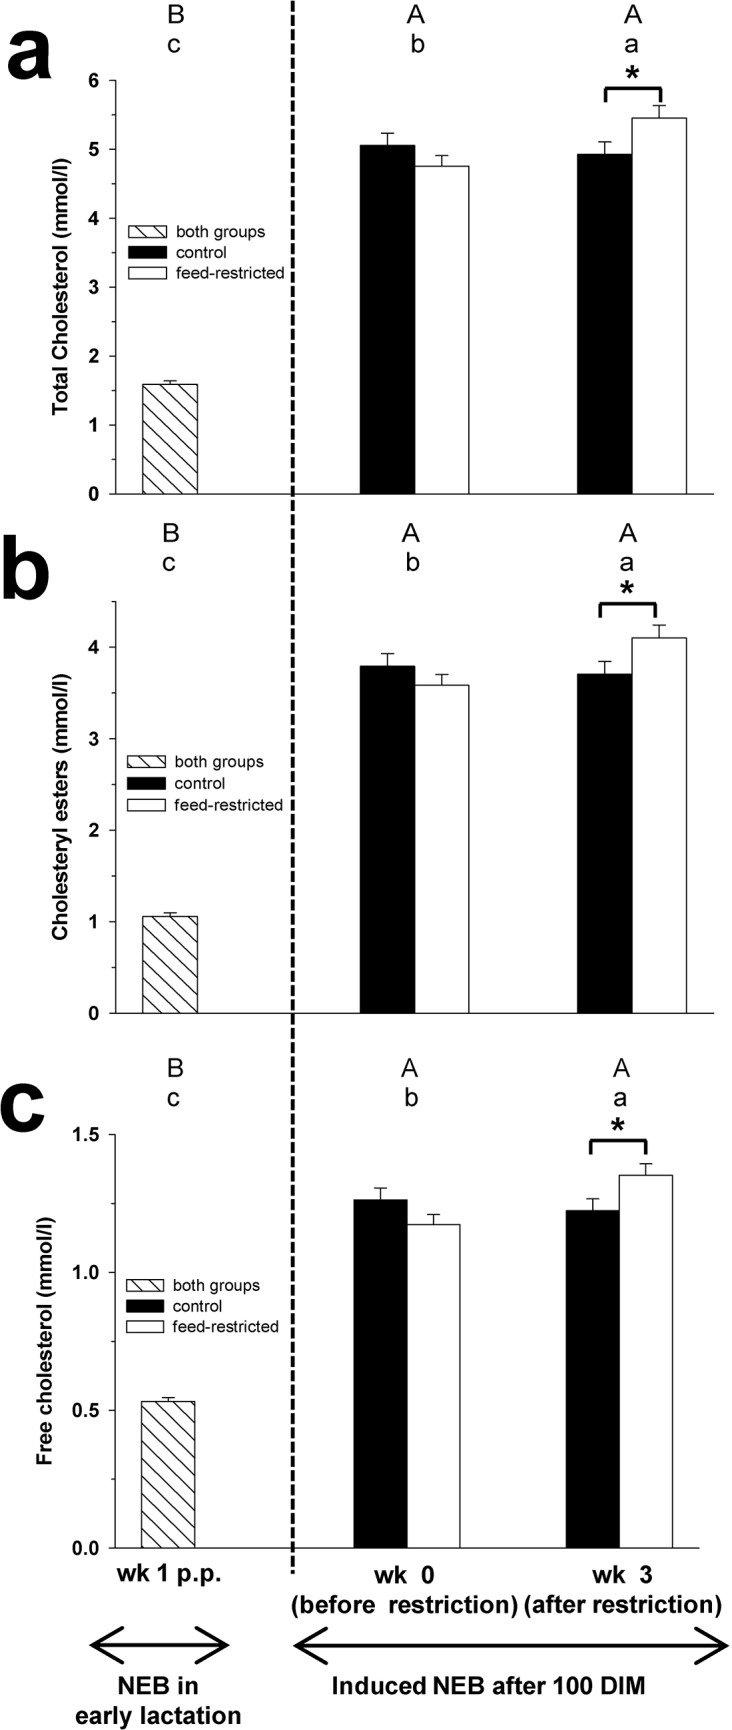
Total cholesterol, cholesteryl esters and free cholesterol.Plasma concentration of total cholesterol (Fig 1a), cholesteryl esters (Fig 1b) and free cholesterol (Fig 1c) in week 1 p.p., and before (week 0) and after (week 3) feed restriction in mid-lactation. Changes over time within the groups are marked with superscripts (A to C for the control group (CON); a to c for the feed-restricted group (RES); P < 0.05). Differences between control (CON) and feed-restricted (RES) group in week 3 are indicated by * (P < 0.05). Data are presented as means ± standard error of the mean.